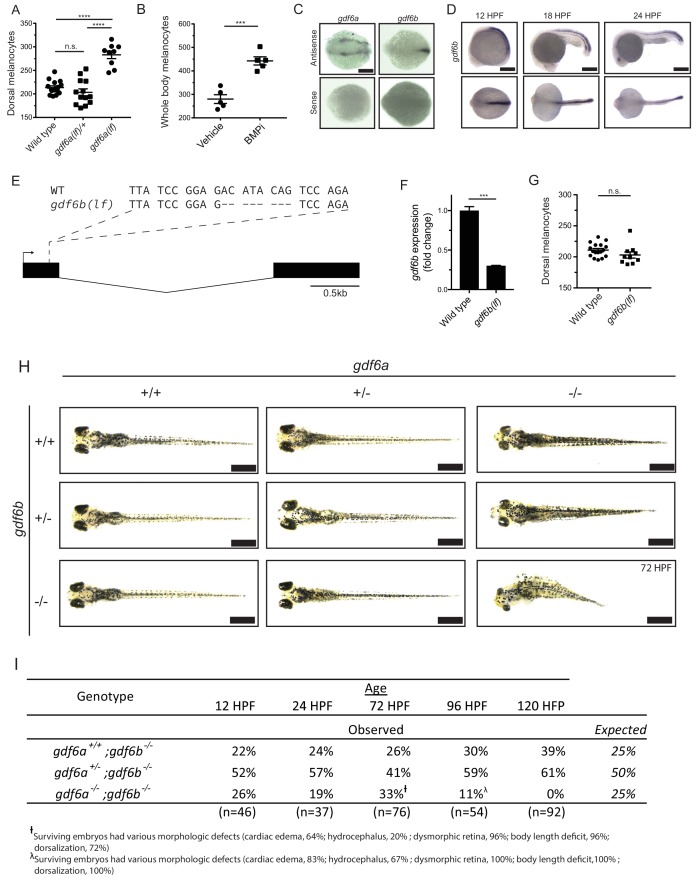
gdf6 paralogs are necessary for normal embryonic development.(A) Quantification of dorsal melanocytes in gdf6a(lf/+) heterozygotes, gdf6a(lf) homozygotes and wild-type embryos. (B) Quantification of whole-body melanocytes in vehicle- and BMPi-treated embryos. (C) Verification of gdf6a and gdf6b probe specificity. (D) RNA in situ hybridization for gdf6b at 12-, 18-, and 24 hr post-fertilization, scale bar = 500 µm. (E) Sequence of gdf6b(lf) mutant indicating deletion and frameshift in exon 1. (F) Decreased gdf6b expression in gdf6b(lf) embryos. (G) Quantification of dorsal melanocytes in gdf6b(lf) mutants compared to wild-type embryos. (H) Images of gdf6a(lf) and gdf6b(lf) mutant combinations. gdf6b(lf) animals have no morphologic defects compared to wild-type embryos at 5 DPF, while gdf6a(lf) animals show pigmentation and eye morphology defects. gdf6a(lf);gdf6b(lf) double mutants show significant morphologic defects associated with gdf6a(lf) as well as decreased body length, cardiac edema and hydrocephalus. Scale bar = 1 mm. (I) Survival of gdf6b(lf) embryos with gdf6a(lf) mutations. †, surviving embryos had various morphologic defects (cardiac edema, 63%; hydrocephalus, 21%; dysmorphic retina, 96%; body length deficit, 96%; dorsalization, 71%). λ, surviving embryos had various morphologic defects (cardiac edema, 83%; hydrocephalus, 67%; dysmorphic retina, 100%; body length deficit, 100%; dorsalization, 100%). Error bars represent mean + /- SEM. P-values were calculated using one-way ANOVA with Tukey’s multiple comparison test for panel A and with Student’s t-test for panels B, F, and G. ***p<0.001, ****p<0.0001, n.s., not significant.